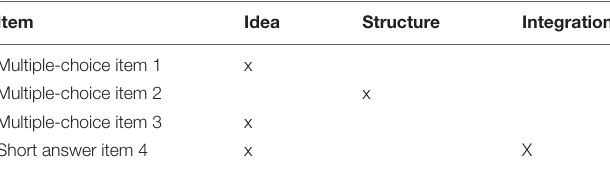
TABLE 1 | Q-Matrix of three reading skills for the multiple-choice and short response items. Item